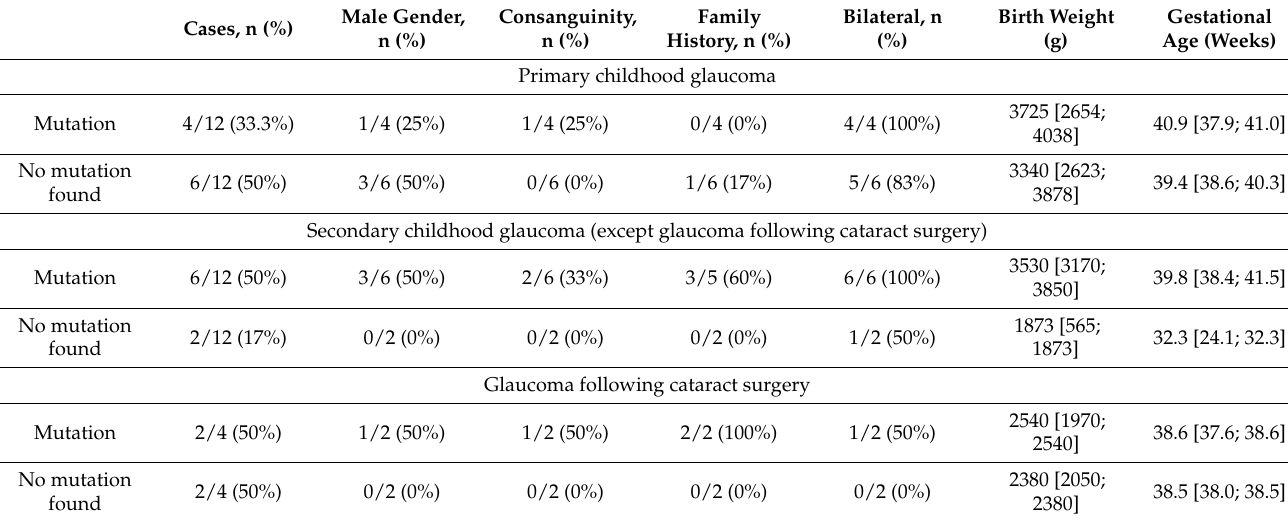
Table 4. Comparison of non-genetic risk factors in patients with and without found mutations.